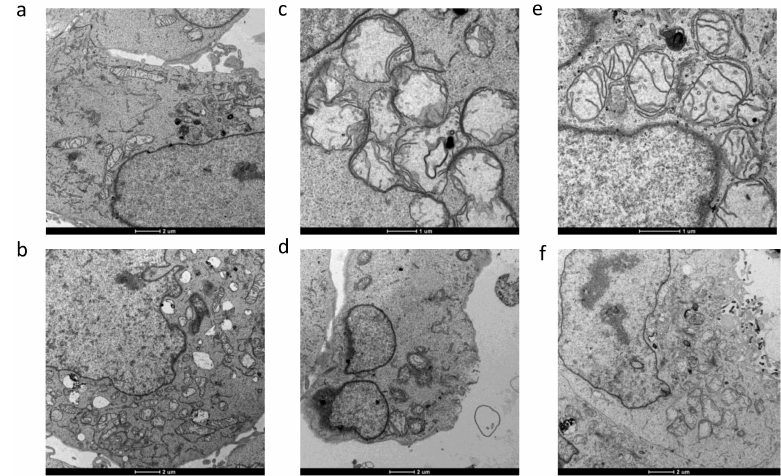
Figure 7. TEM analysis. Transmission electron micrographs of 2008 cells after 48 h treatment with silver(I) complexes ( 5 ) and ( 10 ). ( a ) and ( b ): controls; ( c , d ): ( 5 ); ( e ) and ( f ): ( 10 ).